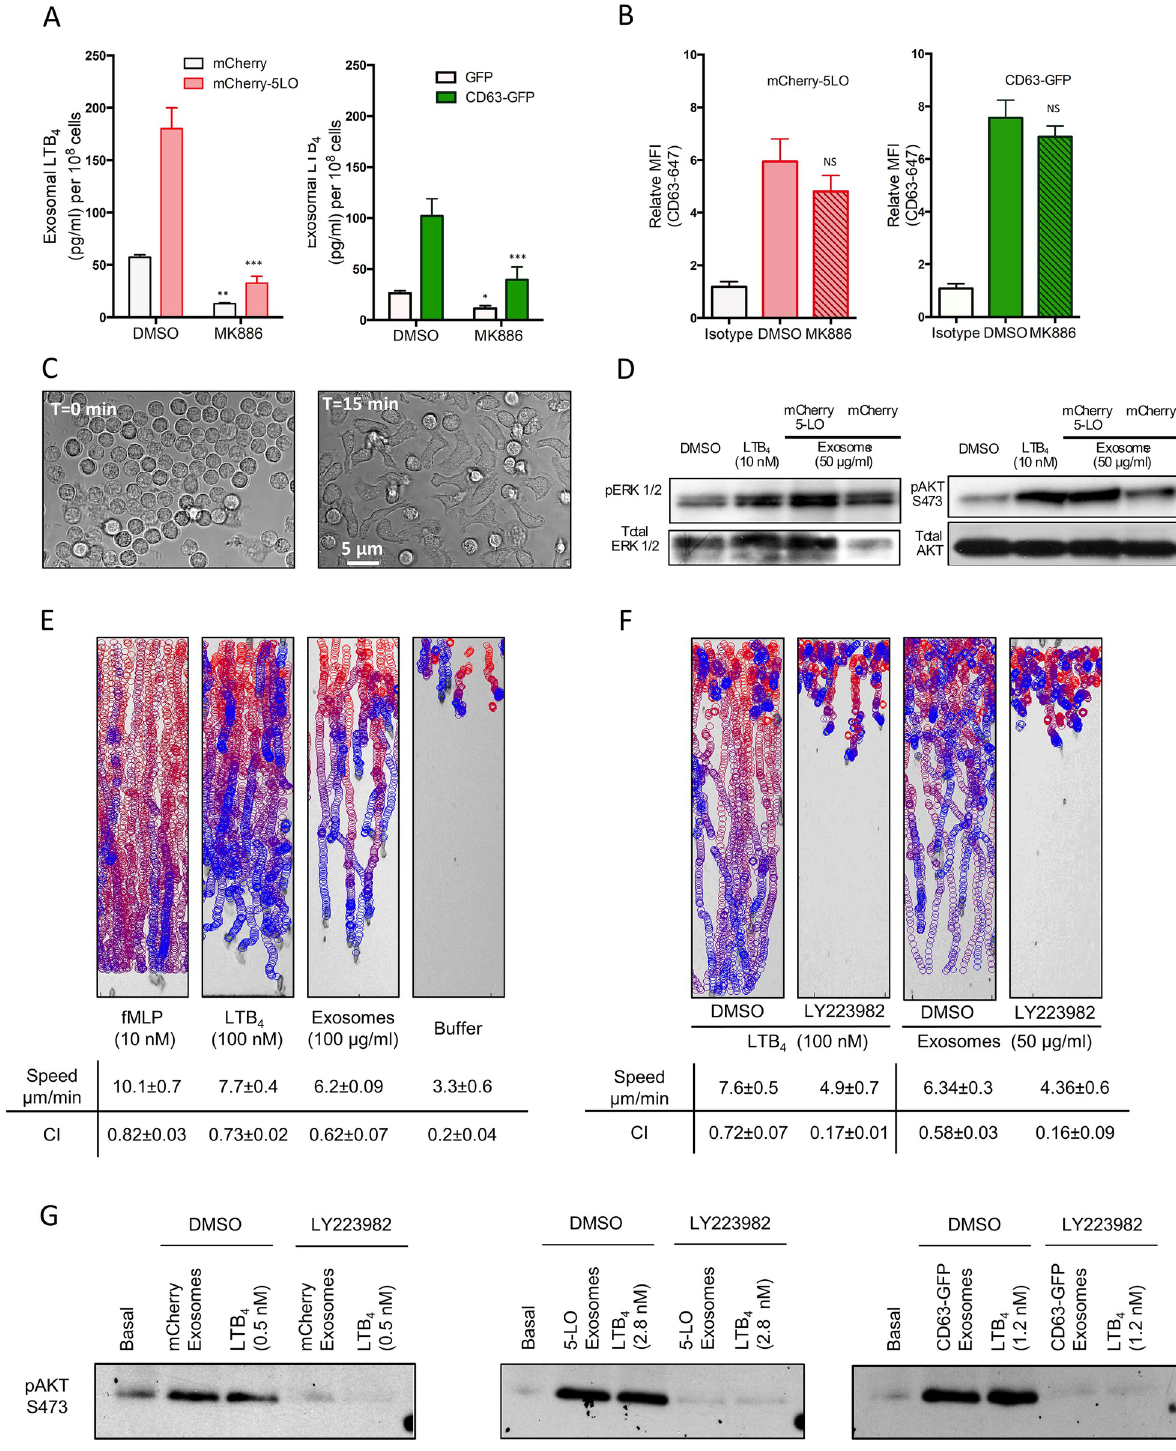
Fig 3. Exosomes activate neutrophils in an LTB 4 -dependent manner. (A) Exosomes were purified from differentiated mCherry-5LO or CD63-GFP cells pretreated with either DMSO or MK886 (1 μ M, 30 min) and subsequently stimulated with 2 nM fMLP. The exosomes were lysed and their LTB 4 content measured by EIA. Results from 4 independent experiments are shown as mean ± SD. The symbols ��� , �� , � , and NS indicate p < 0.0001, p < 0.001, p < 0.01, and p > 0.05, respectively, compared to corresponding DMSO-treated controls. (B) Detection of CD63 on exosomes purified from differentiated mCherry-5LO or CD63-GFP cells that were pretreated with either DMSO or MK886 (1 μ M, 30 min) and subsequently